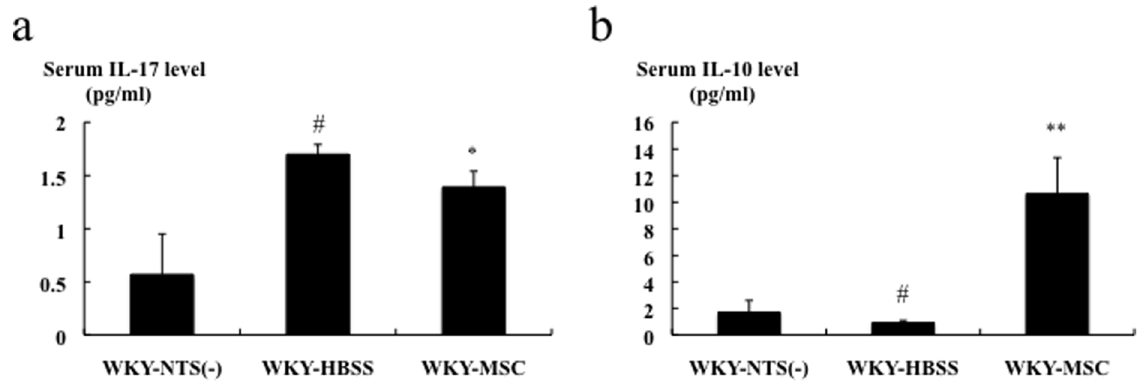
Figure 5. Effects of hMSCs on serum levels of IL-17 and IL-10 in rats with nephritis on day 7. Serum levels of IL-17 and IL-10 in rats with nephritis on day 7 measured by ELISA. Data are expressed as means 6 SEM. Mann-Whitney test: *p , 0.05, **p , 0.01: HBSS-treated rats with nephritis vs. MSC-treated rats with nephritis; # p , 0.05: HBSS-treated rats with nephritis vs. WKY rats without nephritis.